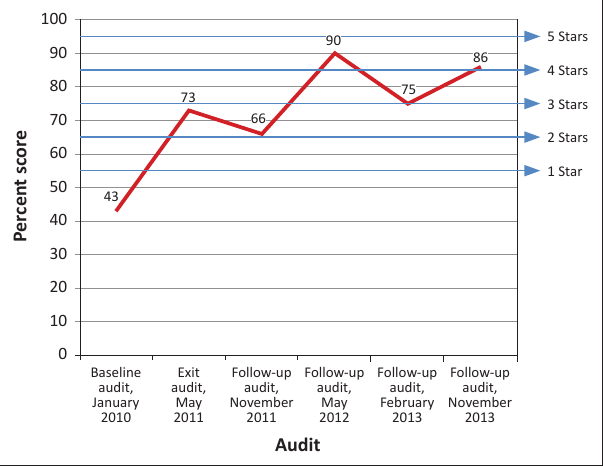
FIGURE 2: Progress of the National Reference Laboratory (NRL) from 2010–2013, based on Stepwise Laboratory Quality Improvement Toward Accreditation (SLIPTA) checklist